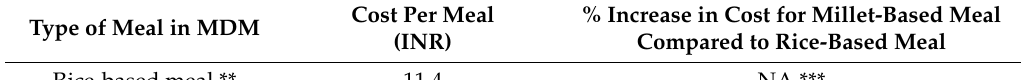
Table 9. Cost per meal for millet-based meal compared to rice in MDM, 2018. Cost Per Meal for Millet-Based Meals Compared to Rice Meals in MDM * Cost Per Meal